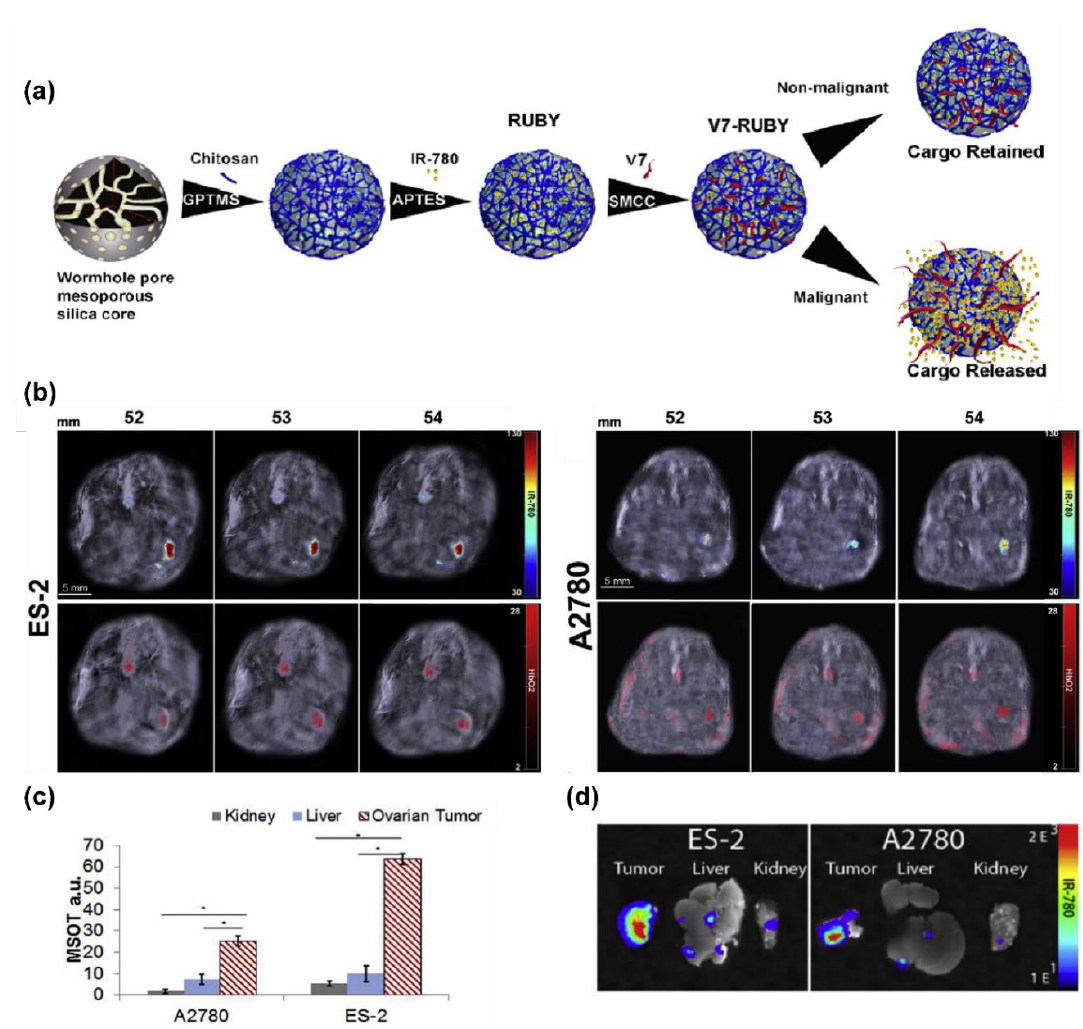
Figure 6. Acidic pH targeted 25 nm mesoporous silica nanoparticles for environmentally sensitive optoacoustic detection and treatment of ovarian cancer developed by Samykutty et al. [133]. ( a ) Schematic representation of the